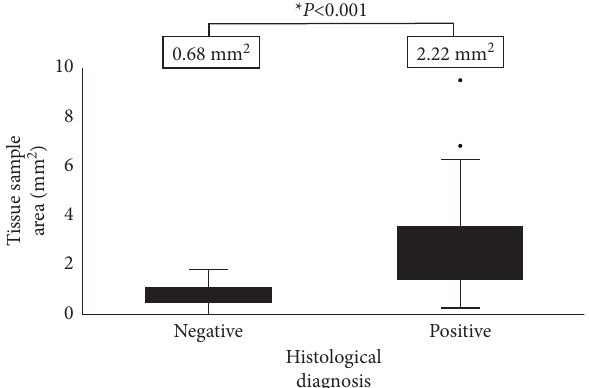
Figure 4: Evaluation of the tissue sample area and diagnostic accuracy. The tissue area was significantly larger in patients who were correctly diagnosed by histology (2.22 mm 2 vs. 0.68mm 2 , P < 0 .